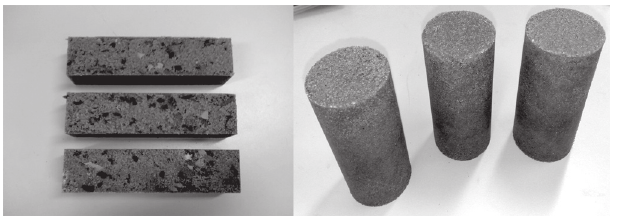
Figure 1. Examples of flexural and compressive specimens.